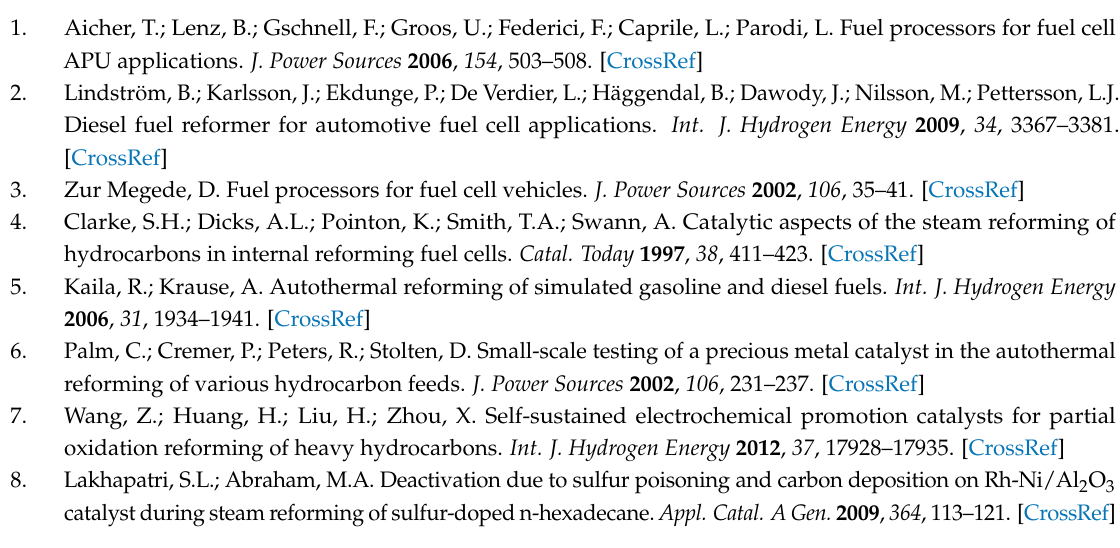
Figure S1: Thermal decomposition of n-dodecane with under S/C = 1.23 and O 2 /C = 0.25 at 750 ◦ C. Figure S2: (a) Nitrogen adsorption-desorption isotherms and (b) XRD patterns of fresh and auto-reduced NA10-PM at various temperature (650, 700, and 750 ◦ C) for 2